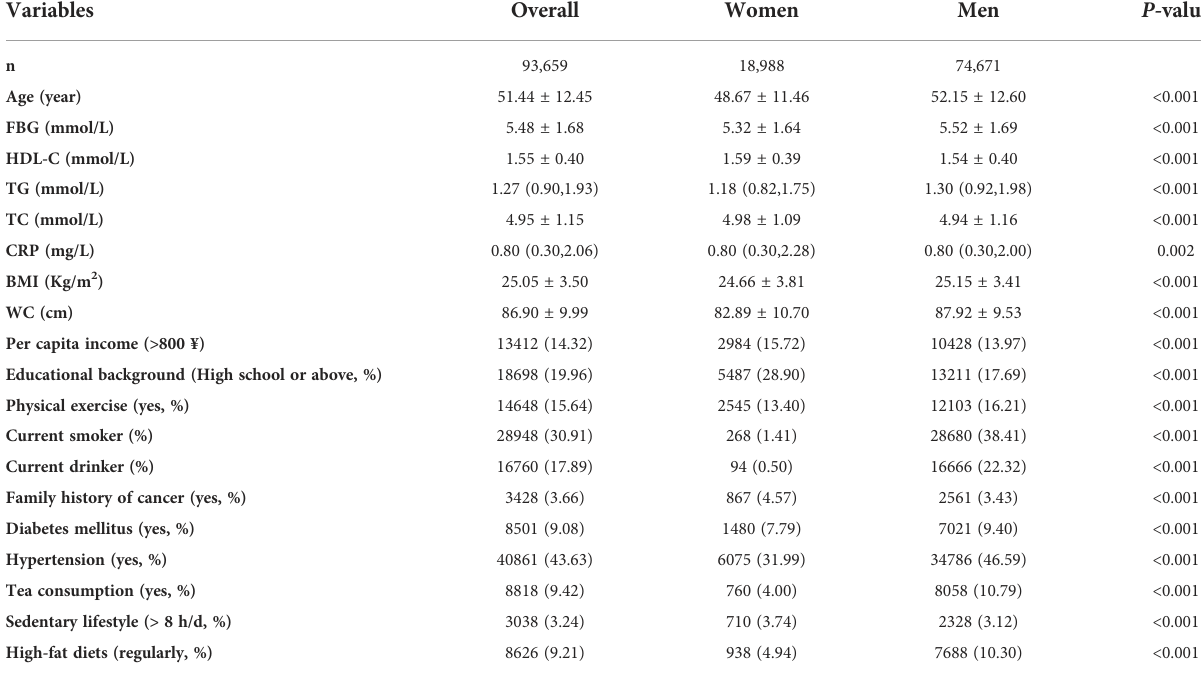
TABLE 1 Baseline characteristics of the participants strati fi ed by sex.